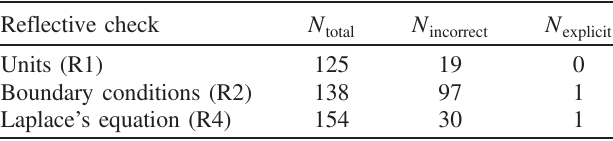
TABLE III. Number of exam students who explicitly utilized each of the three possible reflective checks ( N the number of solutions that included an error that would have been detected by this check ( N number of solutions that could have utilized that reflective